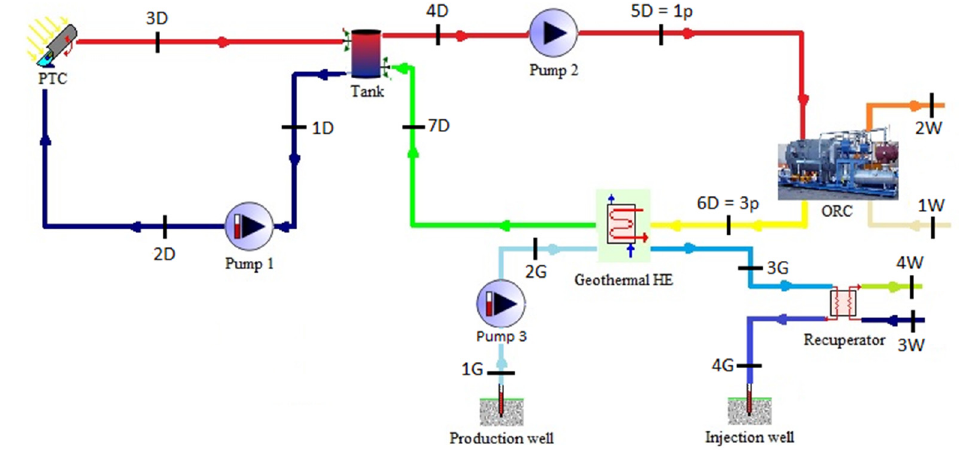
Figure 2. Layout of solar and geothermal